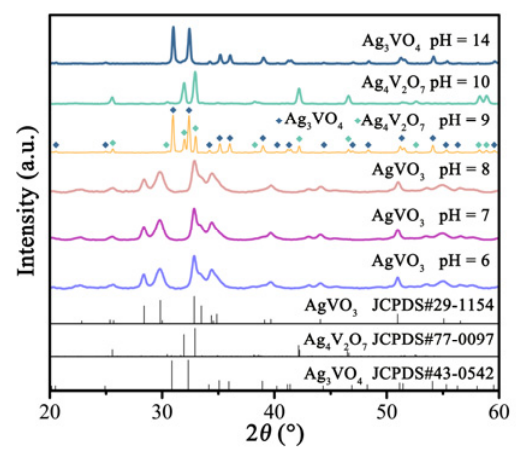
Fig. 2 XRD patterns of AgVO 3 , Ag 3 VO 4 , Ag 4 V 2 O 7 , and BAVO